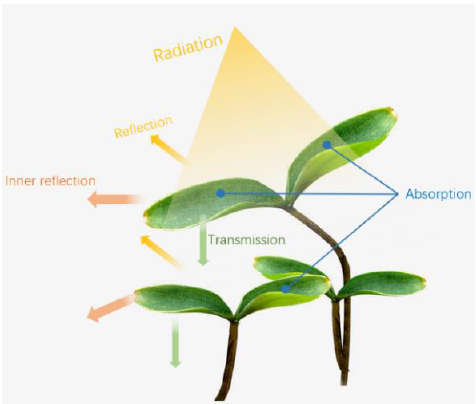
Figure 3. Interaction between natural light and plant leaf surface.